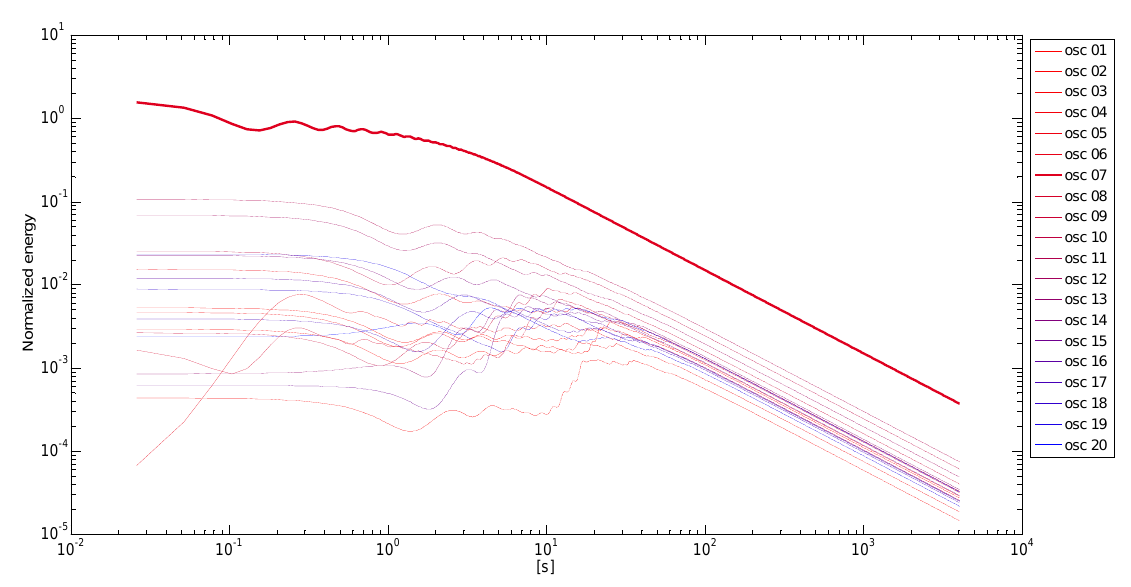
Fig. 13. Chain with mass focus with proportional damping, time energy averages versus time, x, y axes in log